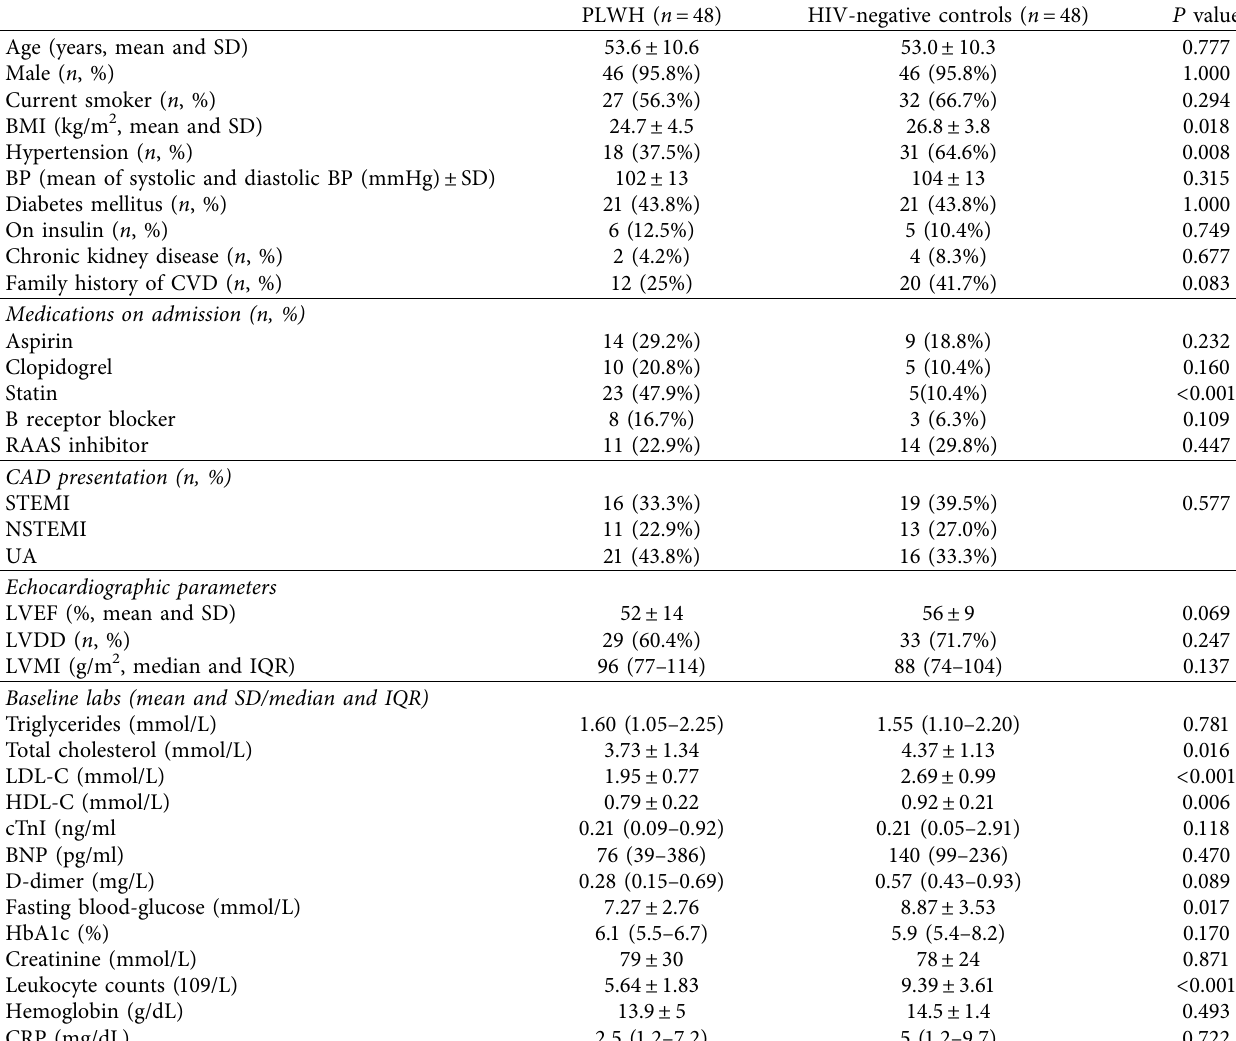
Table 1: The demographic information, previous medical history, and laboratory results at admission compared between PLWH and HIV- negative